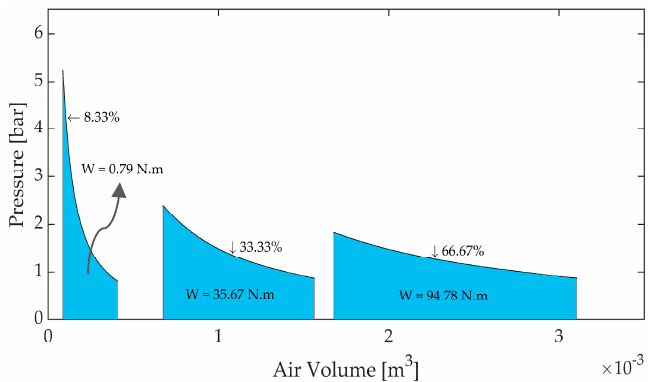
Figure 5. The work done by the air expansion is the area below the pressure–volume graph in di ff erent VFRs.